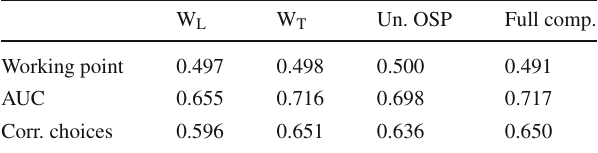
Table 2 Classifier performance in the semi-leptonic channel, using 60 neurons and 4 hidden layers. Results obtained on samples containing a purely longitudinally polarized (W L ) leptonically decaying W boson, a purely transversely polarized (W T ) boson, an unpolarized W boson generated in the OSP PHANTOM framework (Un. OSP) and the full computation with an unpolarized W boson and with non-resonant pro- duction modes included (Full comp.) are shown W L W T Un. OSP Full